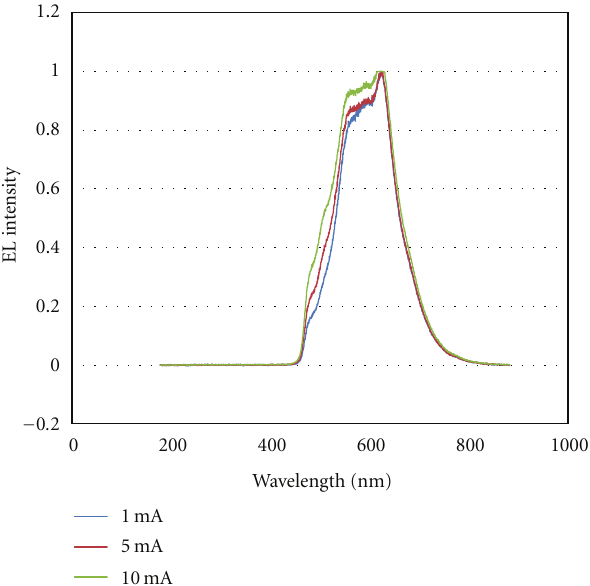
Figure 7: EL spectra in sample C. Injected currents are 1, 5, and 10mA.